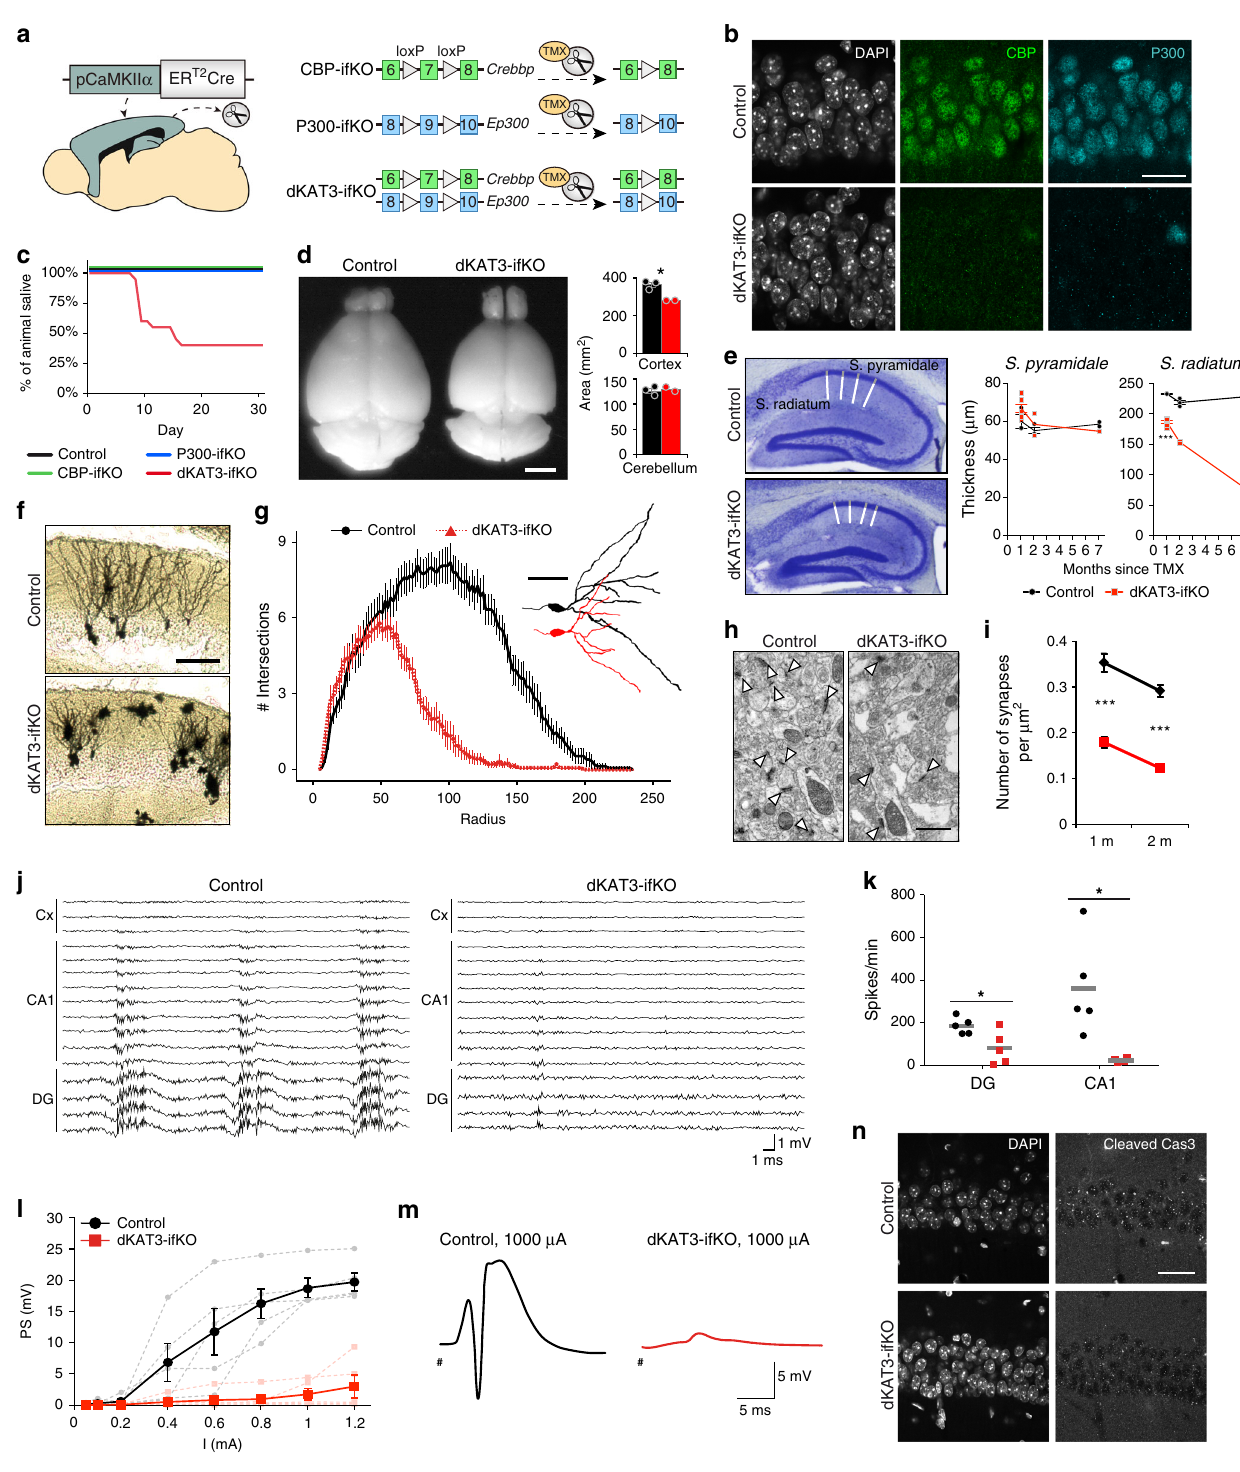
the DG of the Crebbp f/f ::Ep300 f/f (dKAT3- fl oxed) mice with the synapsin promoter (Supplementary Fig. 3e). Immunostaining con fi rmed the ef fi cient and complete elimination of CBP and p300 in granule neurons in the absence of detectable neurode- generation even 10 weeks after genes ablation (Supplementary Fig. 3f,